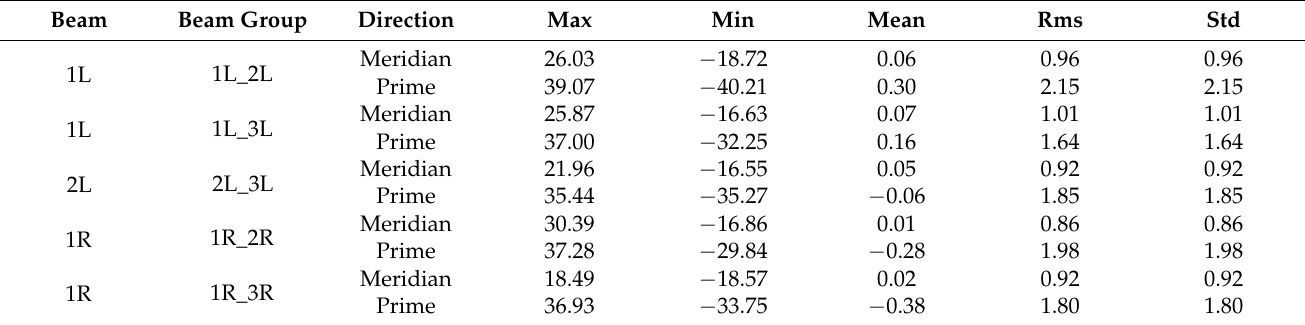
Table 17. Statistics of differences between gridded DOVs calculated by the joint along-cross beam DOVs and the SIO V31.1_DOV model (Unit: